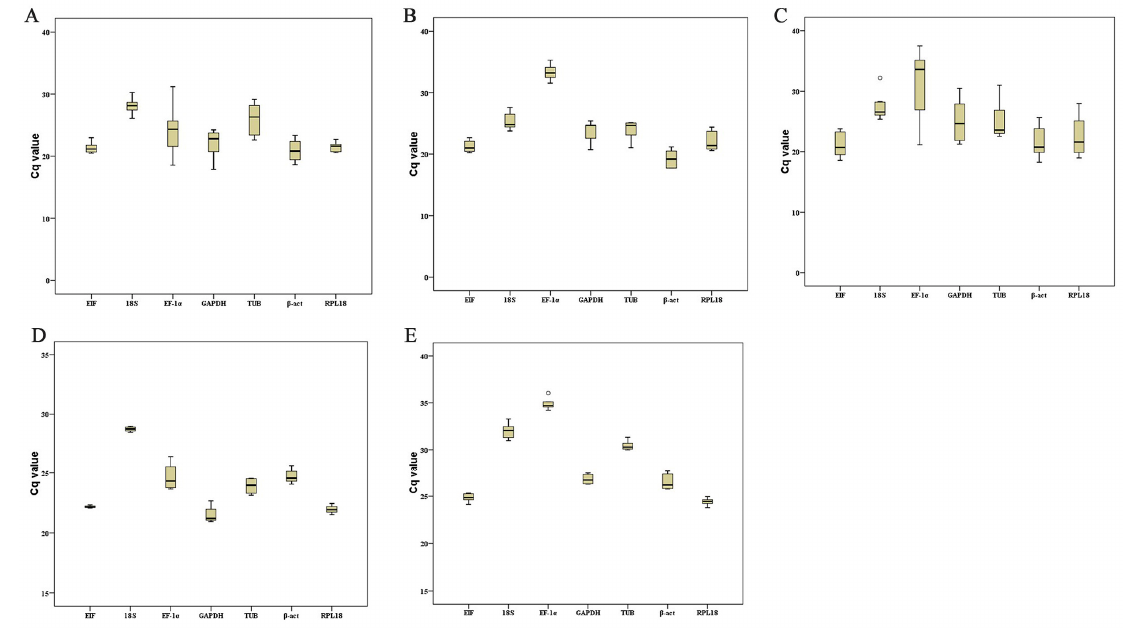
Figure 4. Variation in the reference genes expression using Cq values with boxplot. ( A ) Different tissues in adult shrimps. ( B ) Five different ovary development stages. ( C ) Different embryo development stages. ( D ) Different times after hypoxia stress in gill. ( E ) Different times after infection in hepatopancreas. Upper and lower whiskers mean maximum and minimum values, except outliers, and using a circle to mark the mild outliers and an asterisk to mark the extreme outliers. The upper and lower edges of the box represent the upper and lower quartiles, the middle black line is the median, and the whiskers represent the maximum and minimum values. Mild and extreme outliers are marked by circles and asterisks, respectively. The length of each graphic reflects its variation.